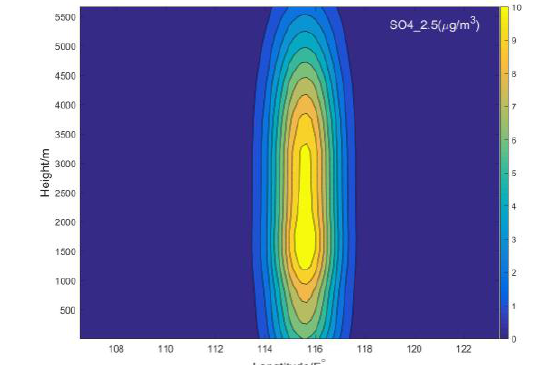
Figure 3 Mass concentrations distribution vertically of the No.3 control variable after data assimilation